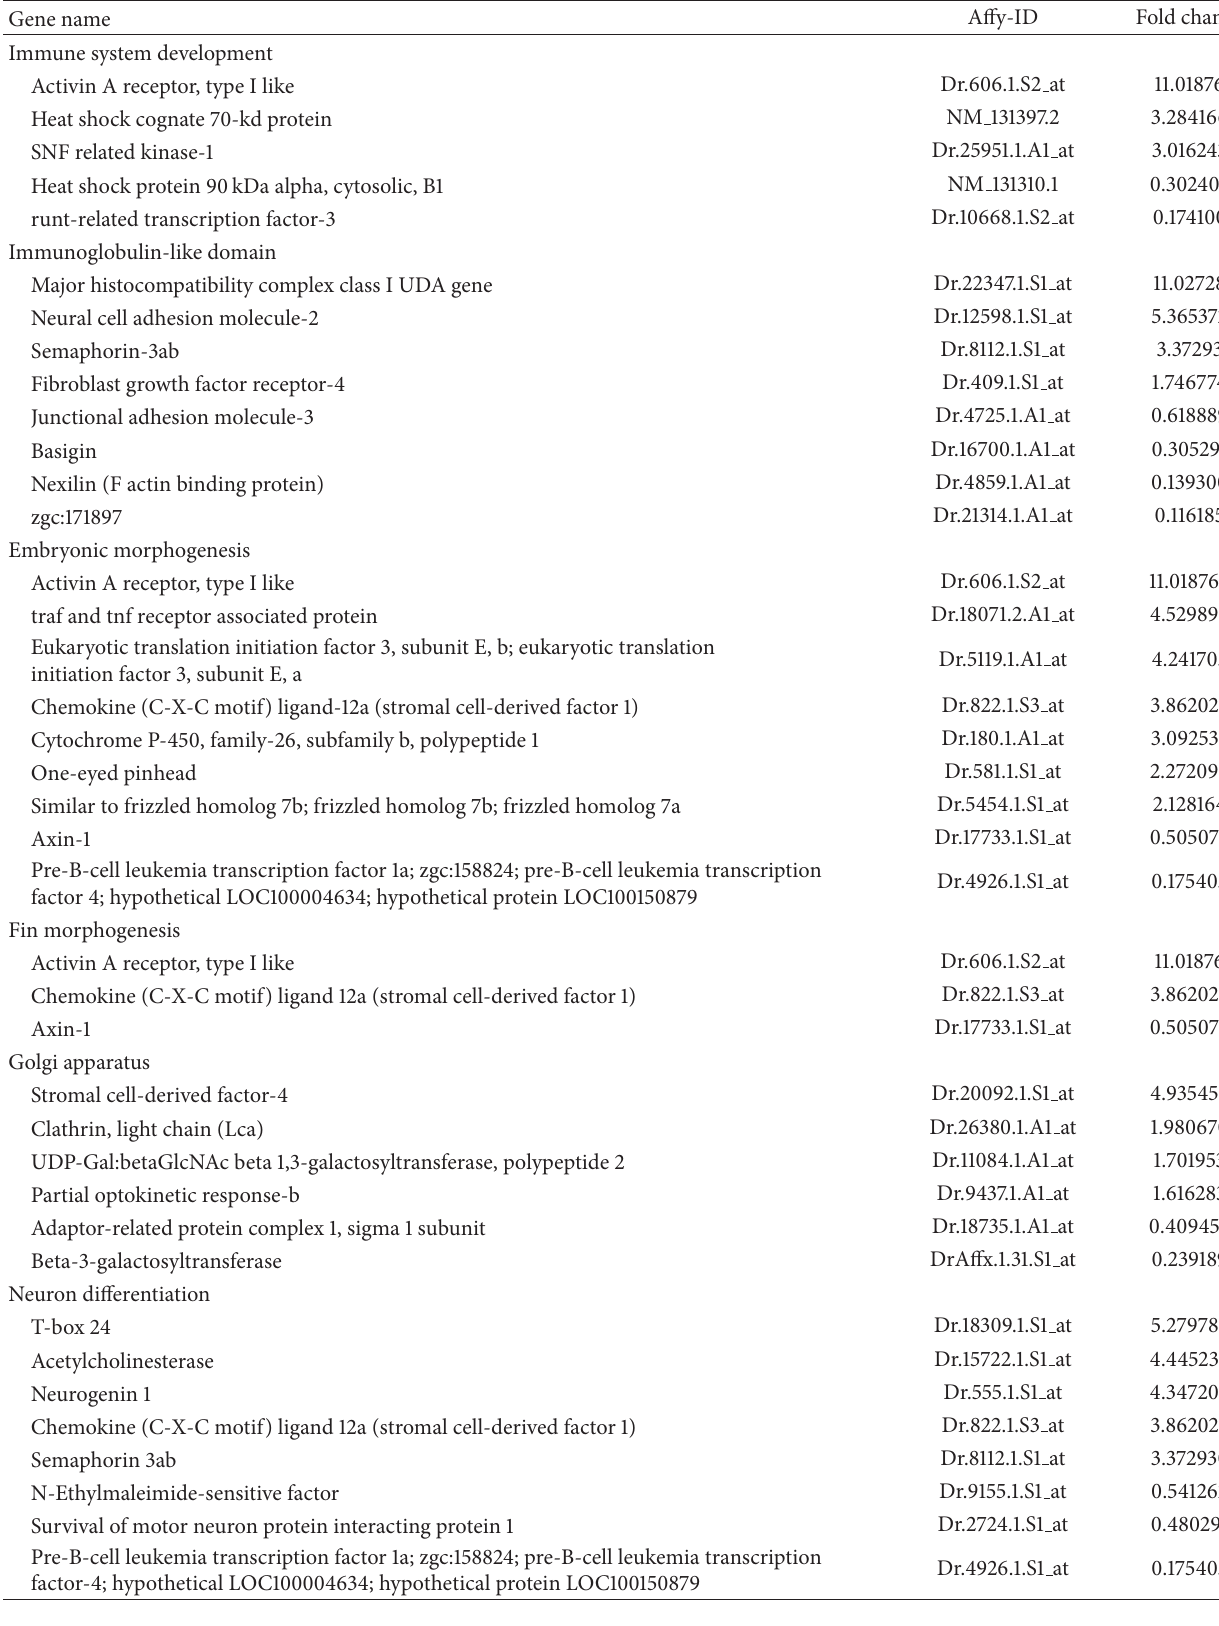
Table 7: Differentially expressed genes involved in other GOs (gene ontology) in the muscle of crisp grass carp and grass